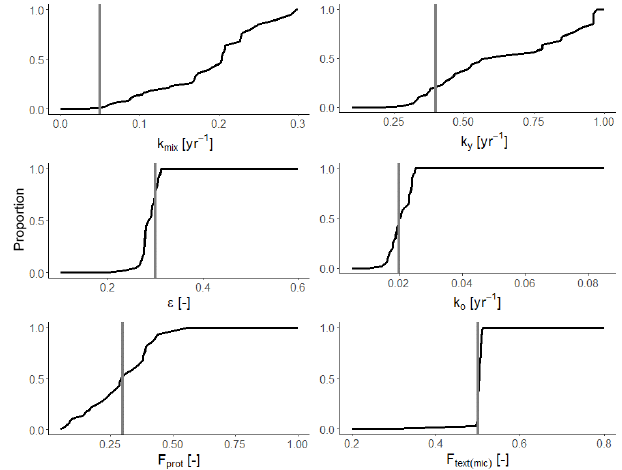
Figure 7. Cumulative frequency distributions of parameter esti- mates for the 36 best parameter sets of 100 calibration runs against synthetic data for soil bulk density, SOC and microporosity. The grey lines mark the true values used to generate the synthetic